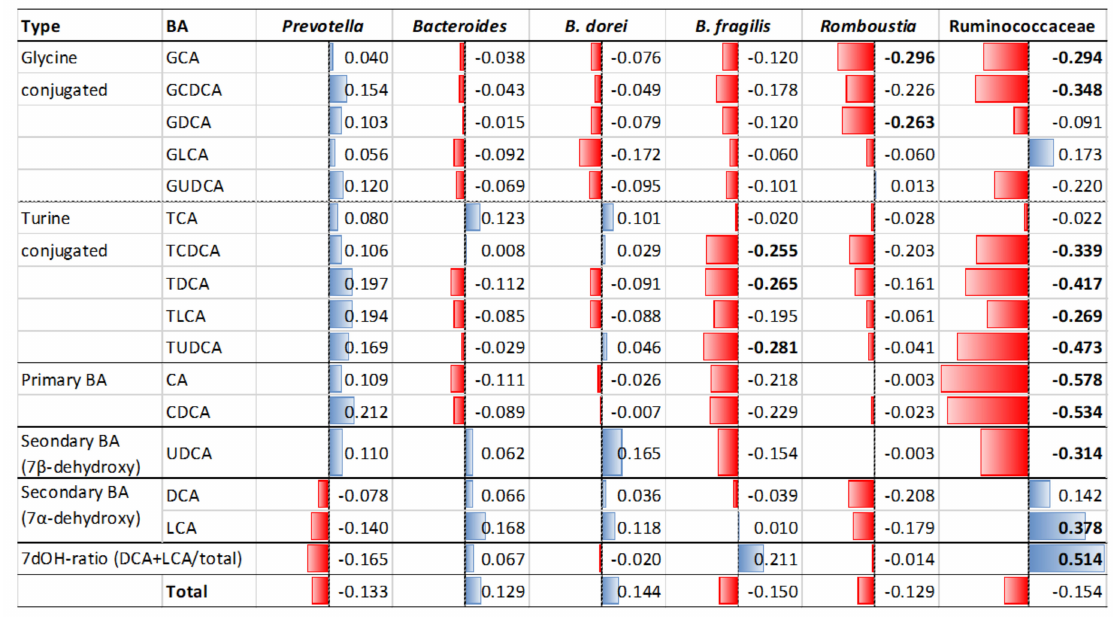
Figure 5. Correlation of the abundance of key taxa with the concentration of bile acid molecules in feces. Spearman correlation between relative abundance of these key taxa and concentration of each bile acid molecule was investigated using fecal samples of 71 Indonesian subjects. Spearman’s rho value was shown. Bold letters represent statistically significance ( p <